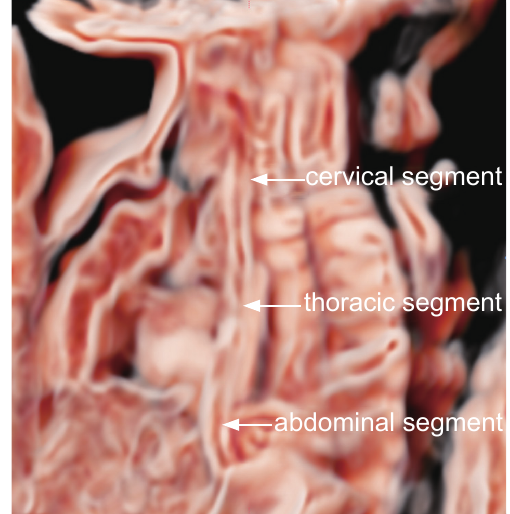
Figure 2 Antenatal visualisation of the intrathoracic and intraabdominal course of the normal foetal oesophagus in the coronal plane using Crystal Vue and Realistic Vue rendering technologies.